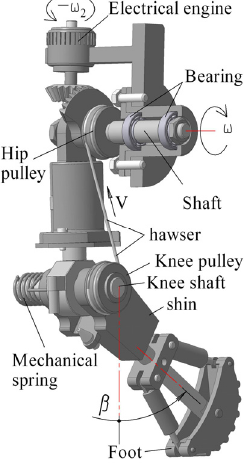
Figure 3. The leg of the robot in a bent position (when the lower leg is rotated to an angle β )